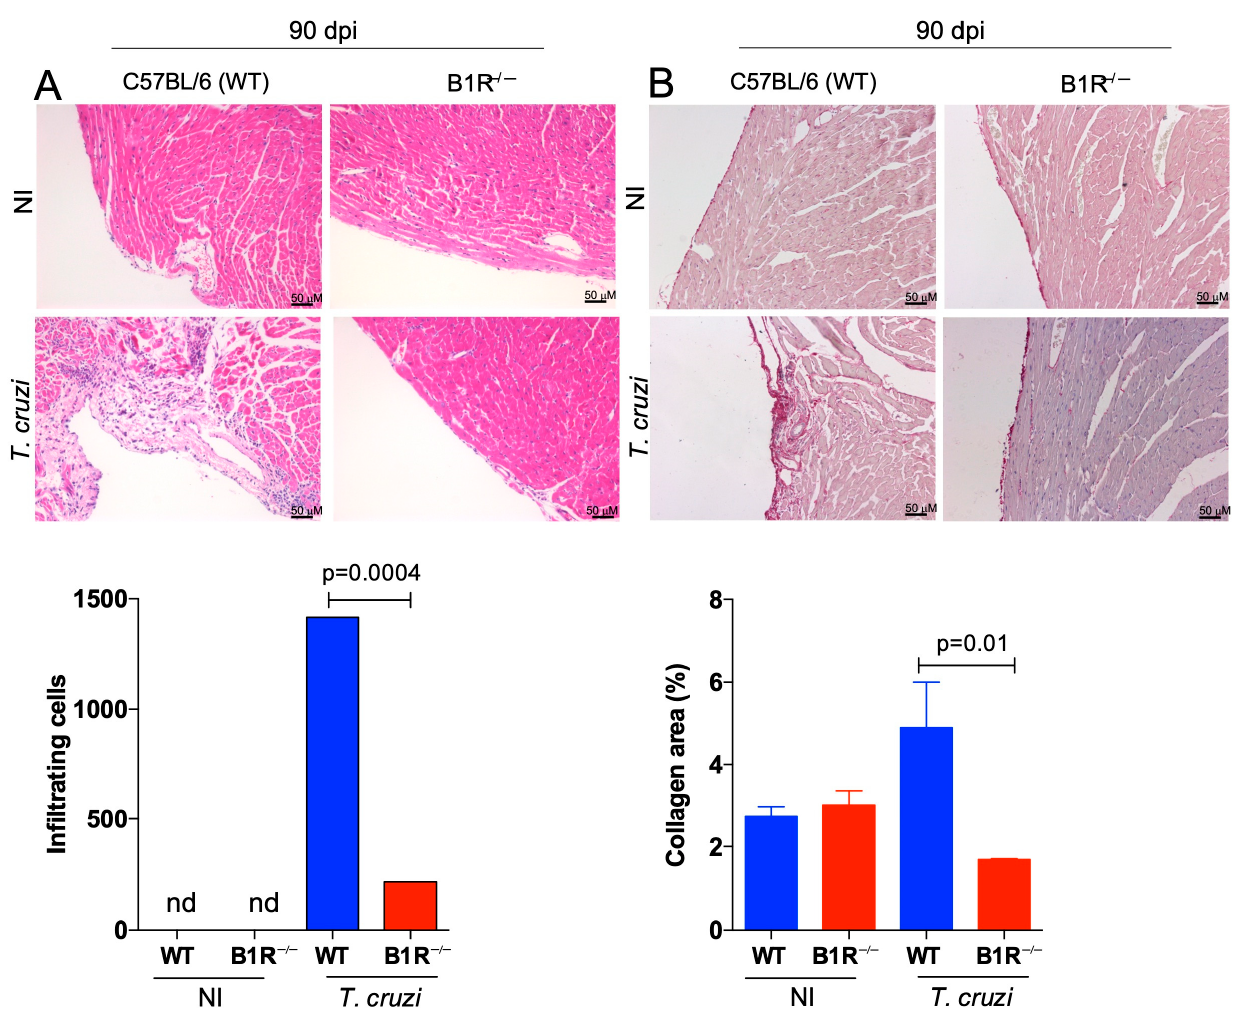
Figure 2. Chronic myocarditis and fibrosis are blunted in T. cruzi -infected B1R − / − mice. C57BL/6 (WT) and B1R − / − mice were infected systemically (i.p.) with a lower dose of Dm28c TCTs (1 × 10 3 TCT). Hearts collected at 90 dpi were fi xed in formalin (5%) and para ffi n-embedded tissue. Hearts sections (4 µm) were stained by H&E to quantify in fl ammatory in fi ltrating cells ( A ) or to measure fi brotic areas (collagen fi bers) by Picrosirius Red staining ( B ). Controls were hearts from non-infected mice (received PBS ip.; NI). The results are representative of three independent experiments (n = 7–10 mice/group/experiment). Statistical analysis was performed by one-way analysis of variance (ANOVA) test. p values < 0.05 were considered signi fi cant. nd, non-detected.